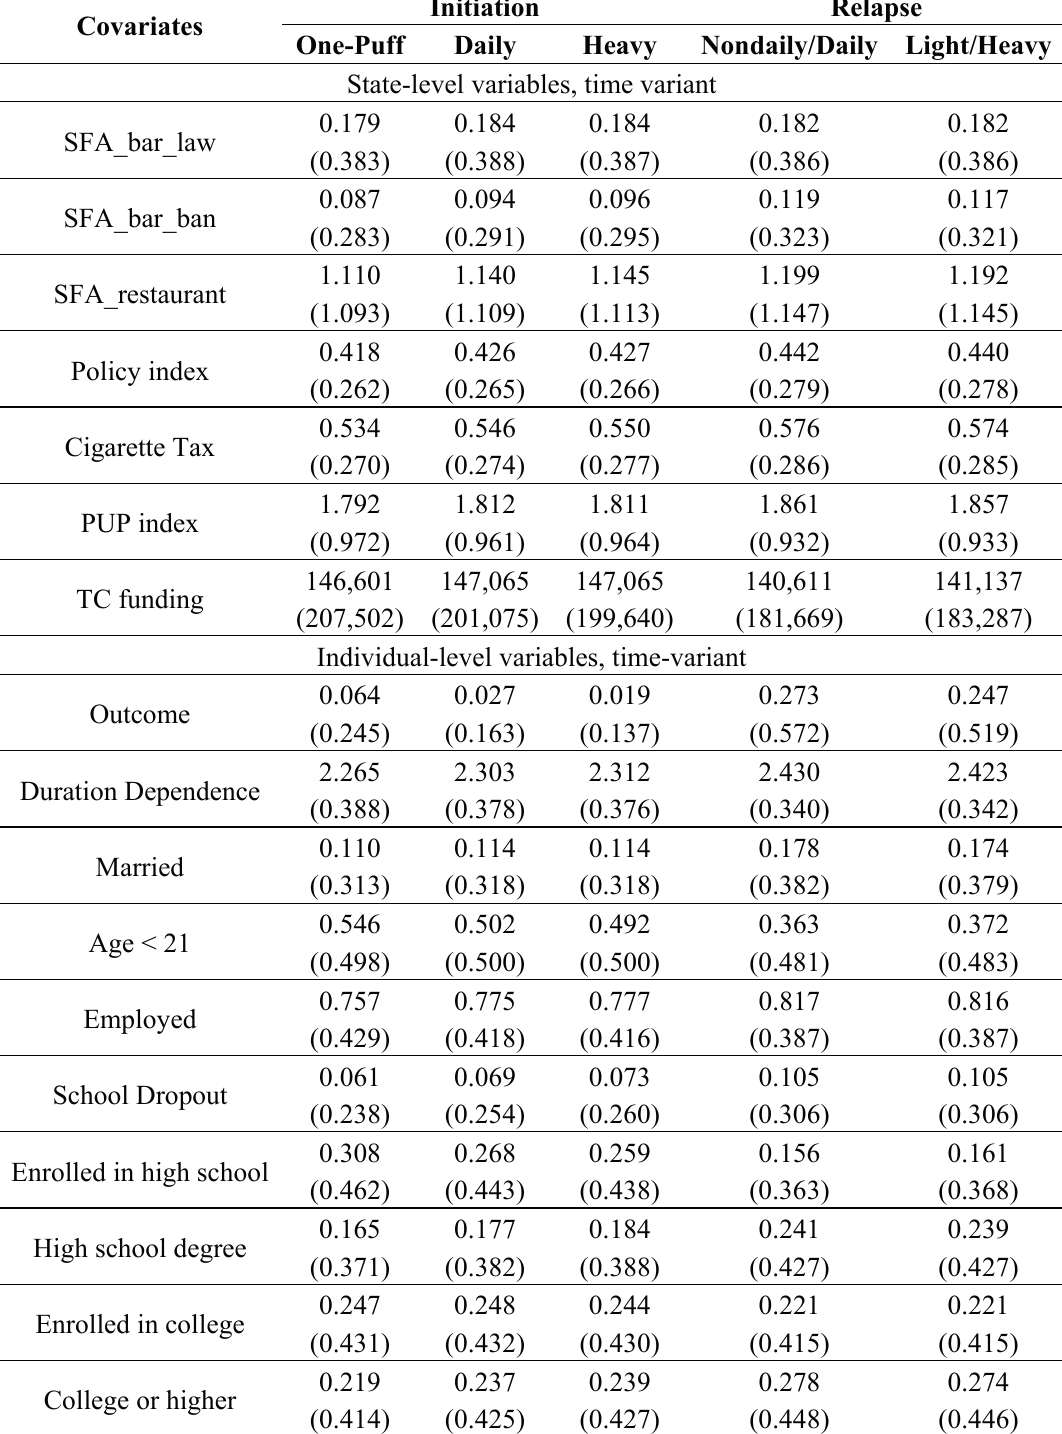
Table 2. Descriptive statistics for the six smoking transition samples NLSY97,